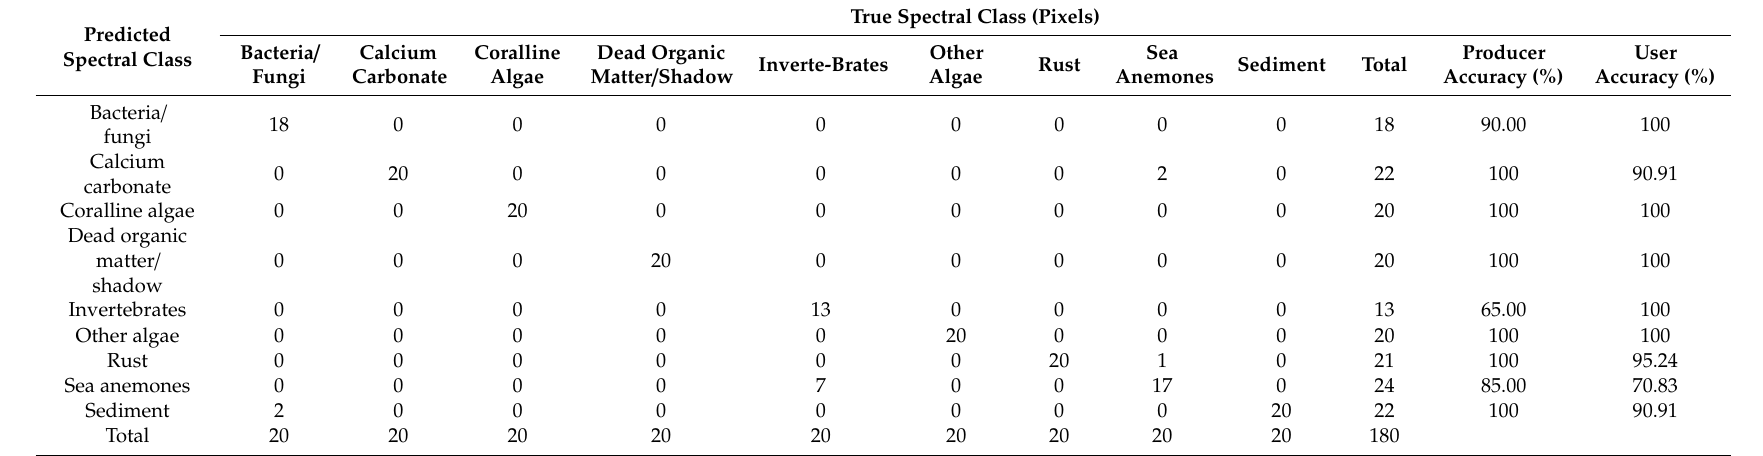
Table 2. Confusion matrix from the test set validation of the support vector machine (SVM) classifier used in the current study, and corresponding accuracy assessments. Predicted Spectral Class